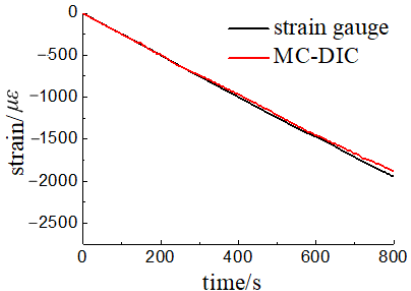
Figure 20. Results comparison of MC-DIC and strain gauge.